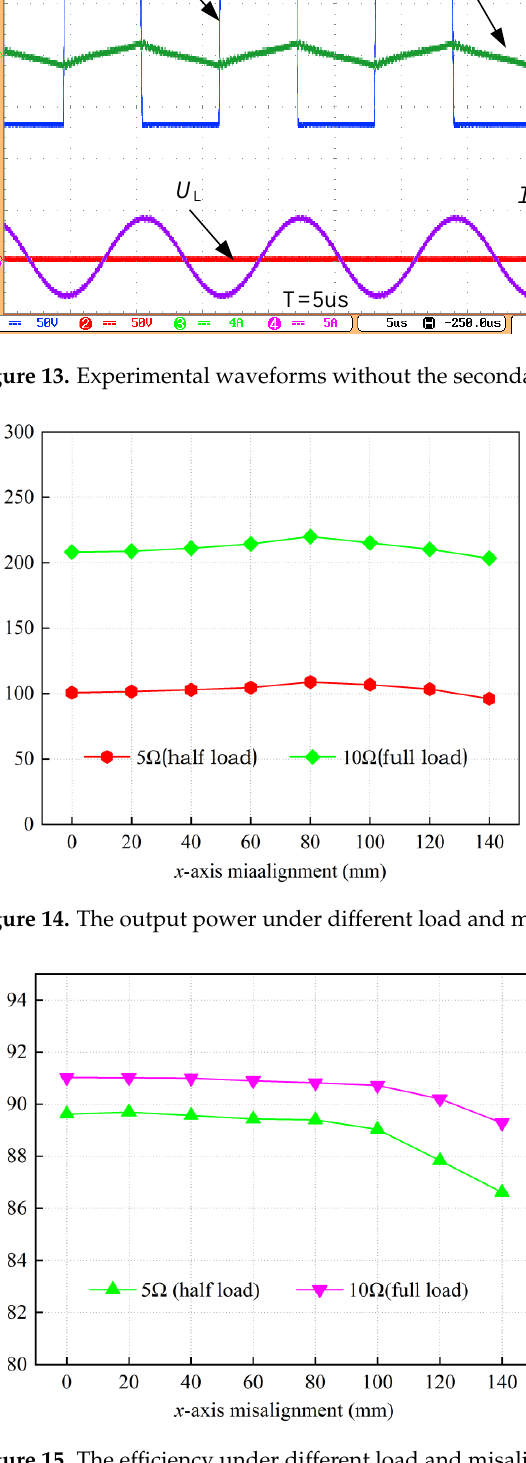
Figure 13. Experimental waveforms without the secondary side.